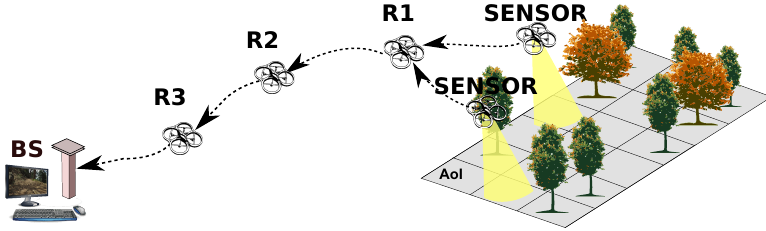
Figure 1. Our vision of an aerial multi-hop sensor network, streaming to a base station through a backbone of relaying